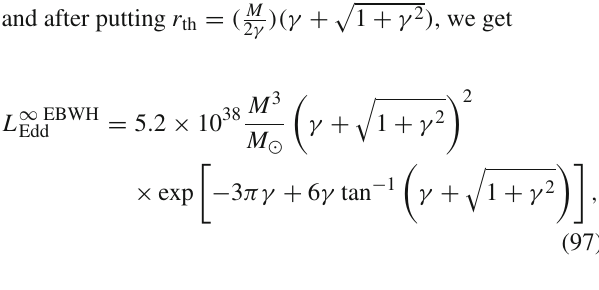
and after putting r th = ( M